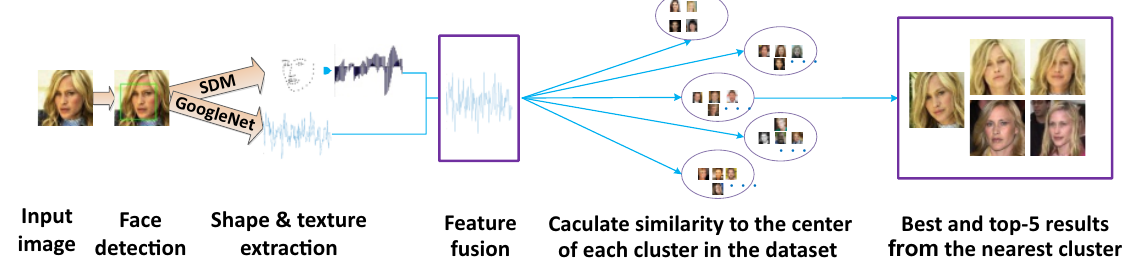
Fig. 2 Proposed large-scale face retrieval